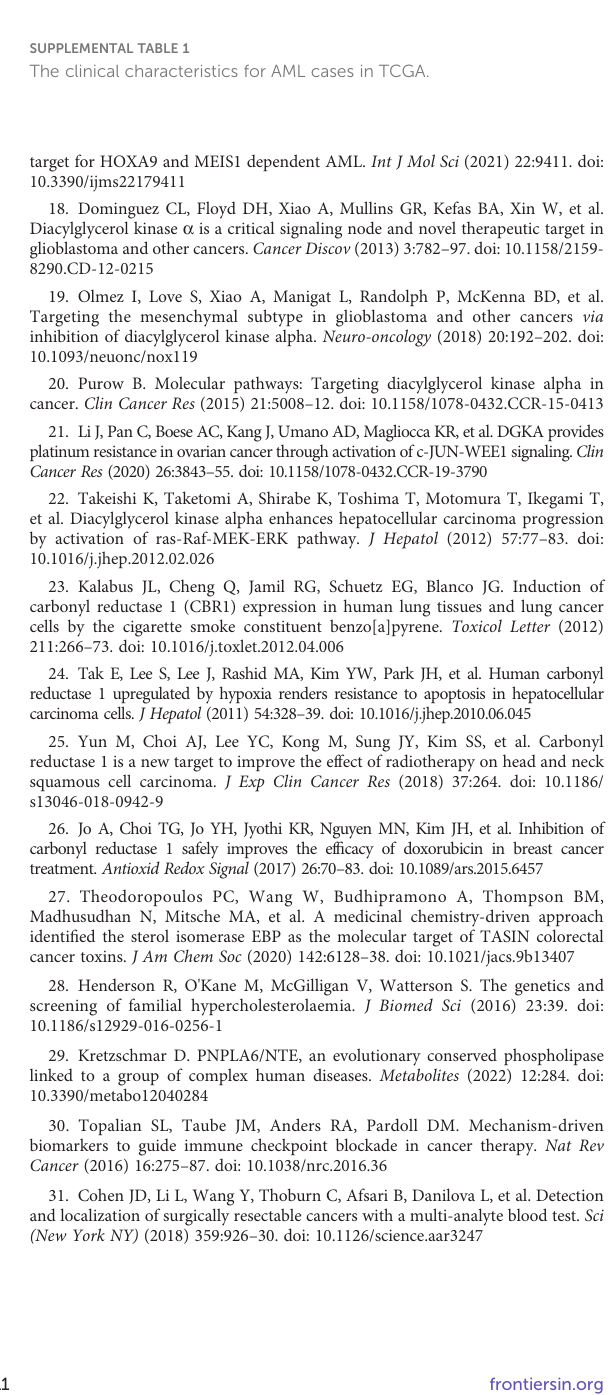
SUPPLEMENTAL FIGURE 4 The expression levels of these six genes in patient samples from TCGA.